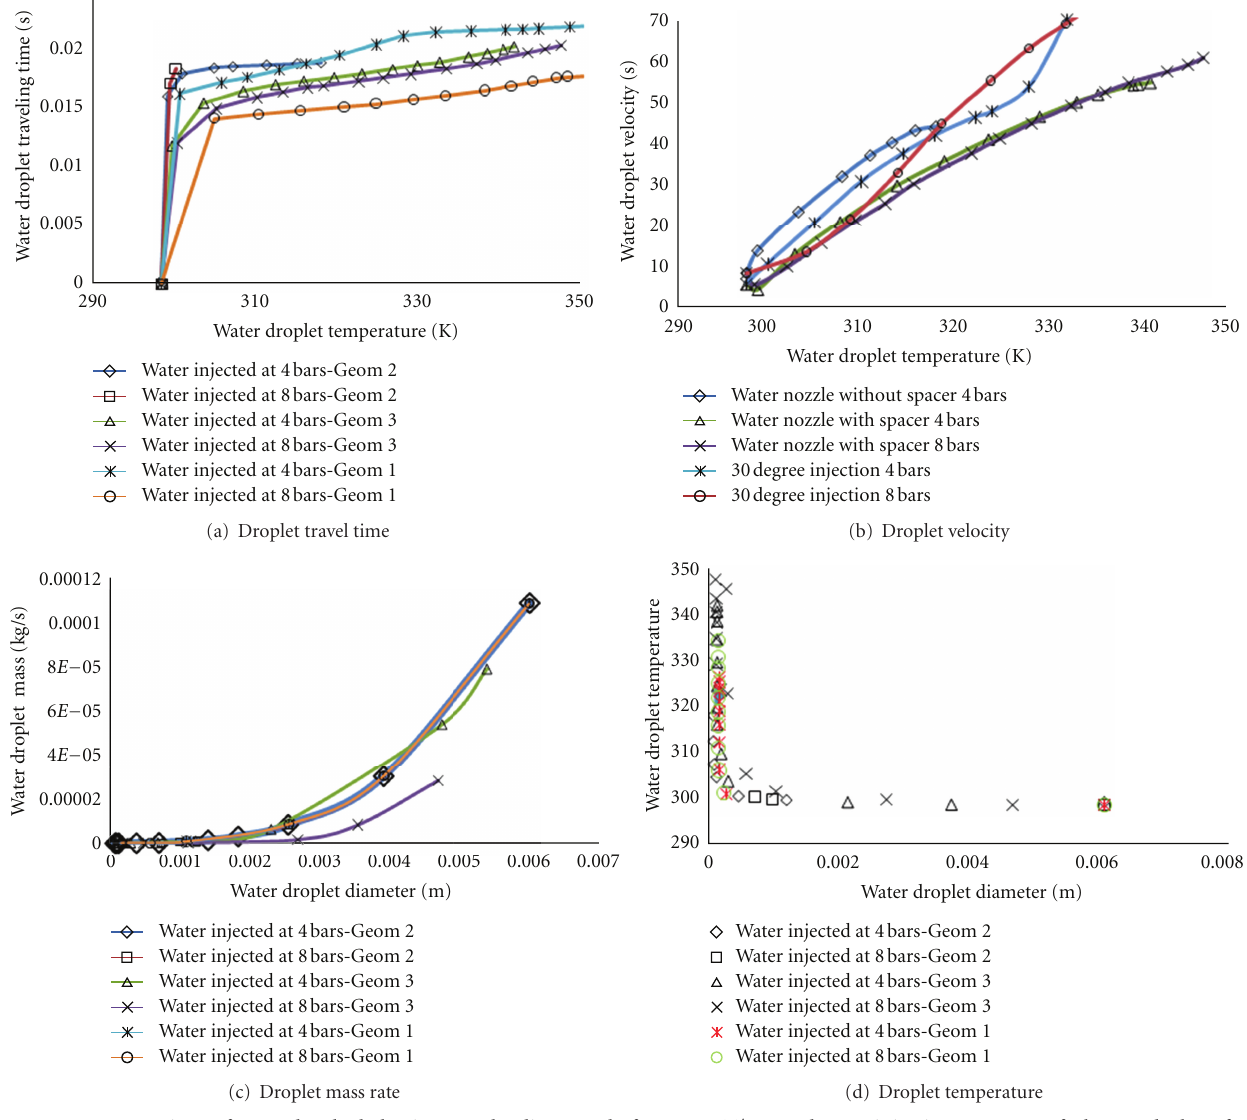
Figure 8: Comparison of water droplet behaviour at a loading speed of 800 rpm/T ∧ 0.5 and water injection pressures of 4 bars and 8 bars for all three nozzles